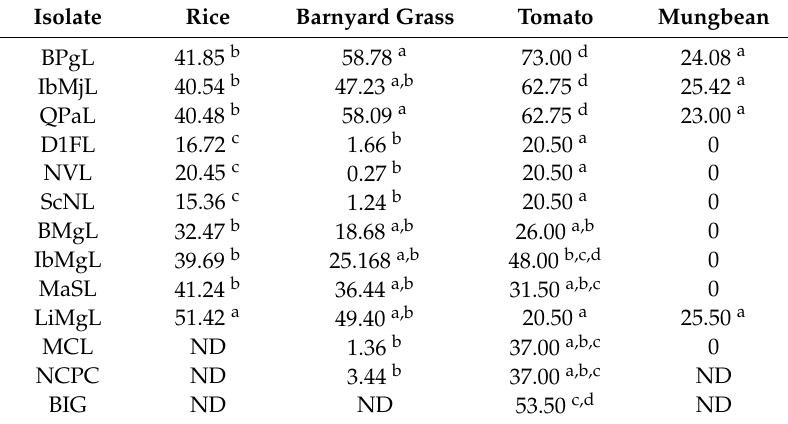
Table 4. Disease severity on rice var. TN1, barnyard grass, tomato var. Athena, and mungbean var. Pagasa 3 with selected Rhizoctonia